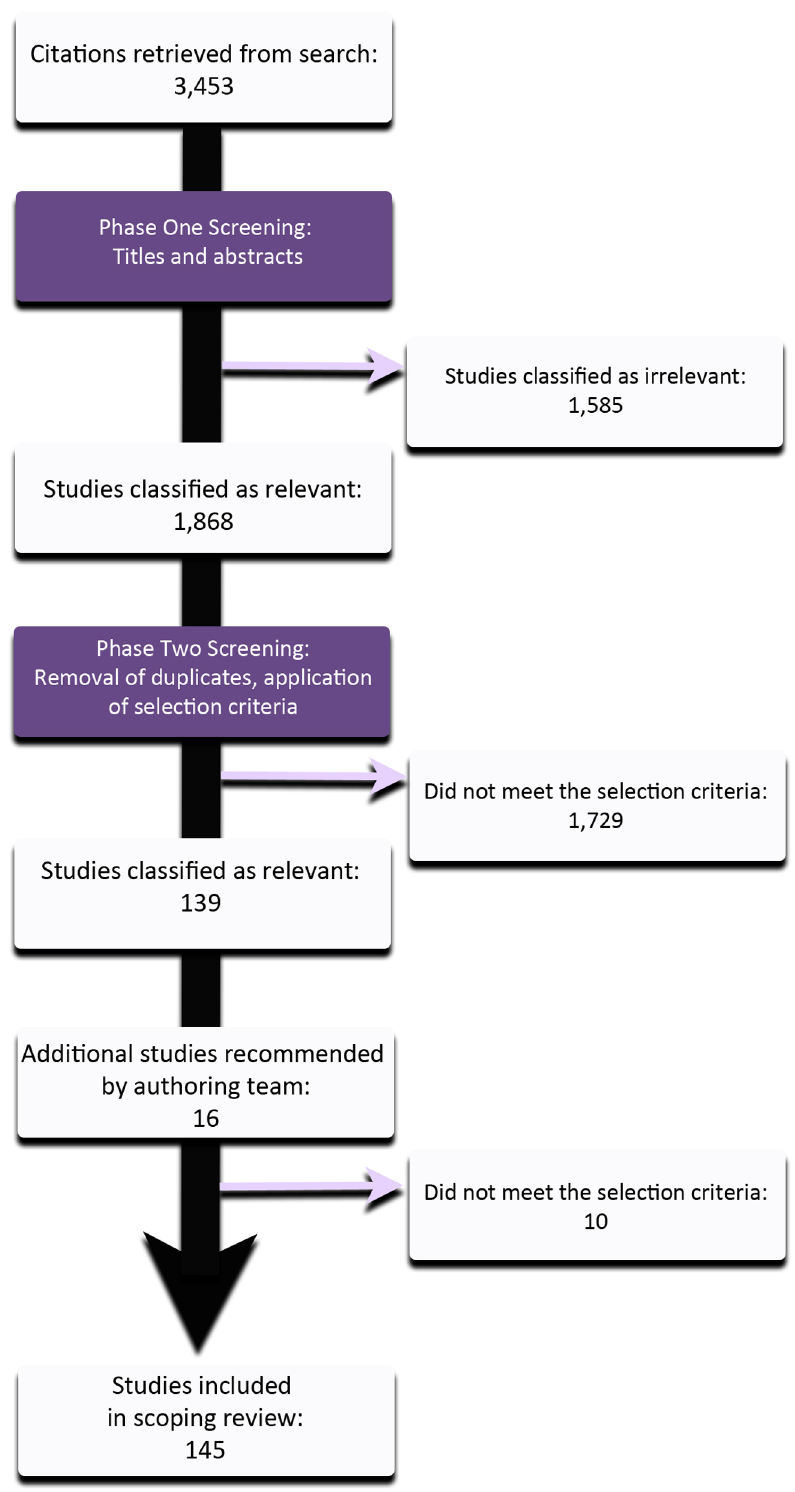
Fig 1. Flow diagram of studies included in this